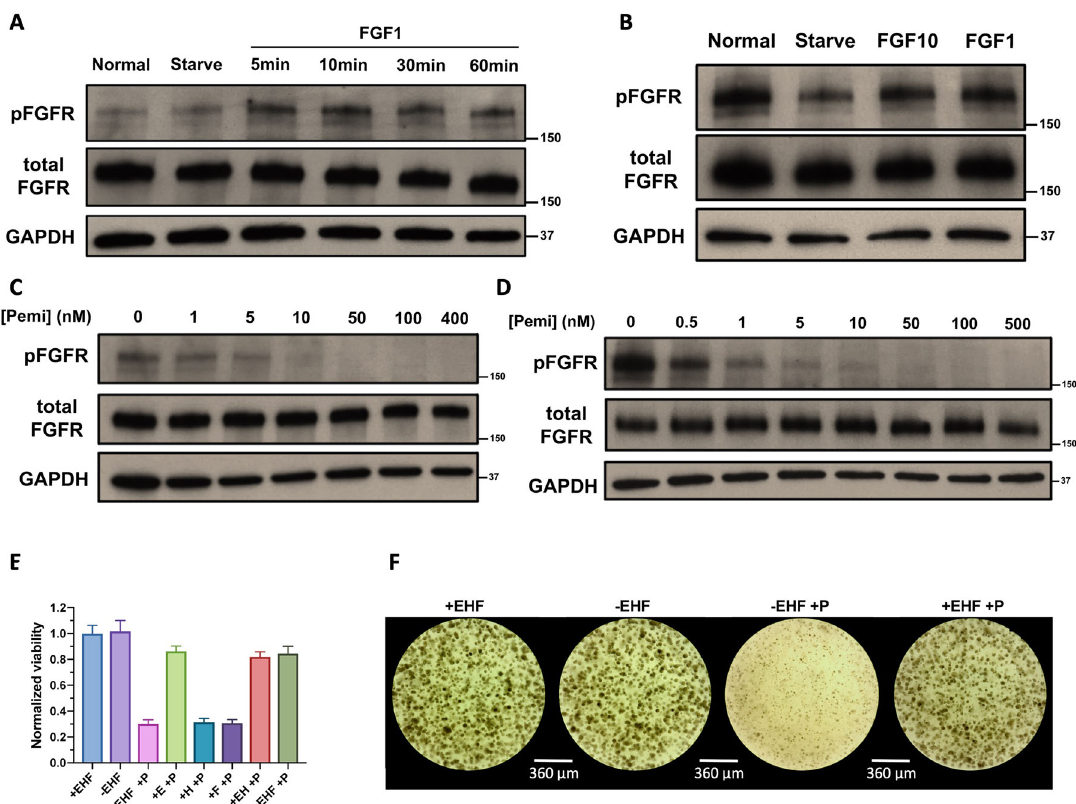
Fig. 3 FGFR2-G3BP2 kinase is constitutively active and sensitive to FGFR inhibition. A FGFR2 kinase activity is constitutively active in the PDC-DUC18828 model. FGFR kinase activation is examined by western blot under the condition of complete culture media (Normal), serum-free media (Starve), and FGF1 stimulation for 5, 10, 30, and 60 min (FGF1 5, 10, 30, 60 min). FGFR is phosphorylated (activated) to a similar extent in serum-free media when compared to cells grown in complete culture media, con fi rming constitutive activation, which is further augmented with FGF1 stimulation, B FGFR2 kinase activity is constitutively active in the PDO-DUC18828 model. FGFR kinase activation is examined by western blot under the condition of complete culture media (Normal), nutrient-free media (Starve), FGF10 stimulation for 60 min (FGF10), and FGF1 stimulation for 60 min (FGF1). FGFR phosphorylation remains detectable, even in nutrient-free media, con fi rming constitutive activation, which is further augmented by FGF10 and FGF1 stimulation. C FGFR kinase activation is sensitive to pemigatinib (Pemi), an FDA-approved selective FGFR inhibitor, in the PDC-DUC18828 model. FGFR kinase activation is examined by western blot after treatment with pemigatinib (Pemi) doses shown, with signi fi cant reduction in activity starting at 10 nM. D FGFR kinase activation is sensitive to pemigatinib in the